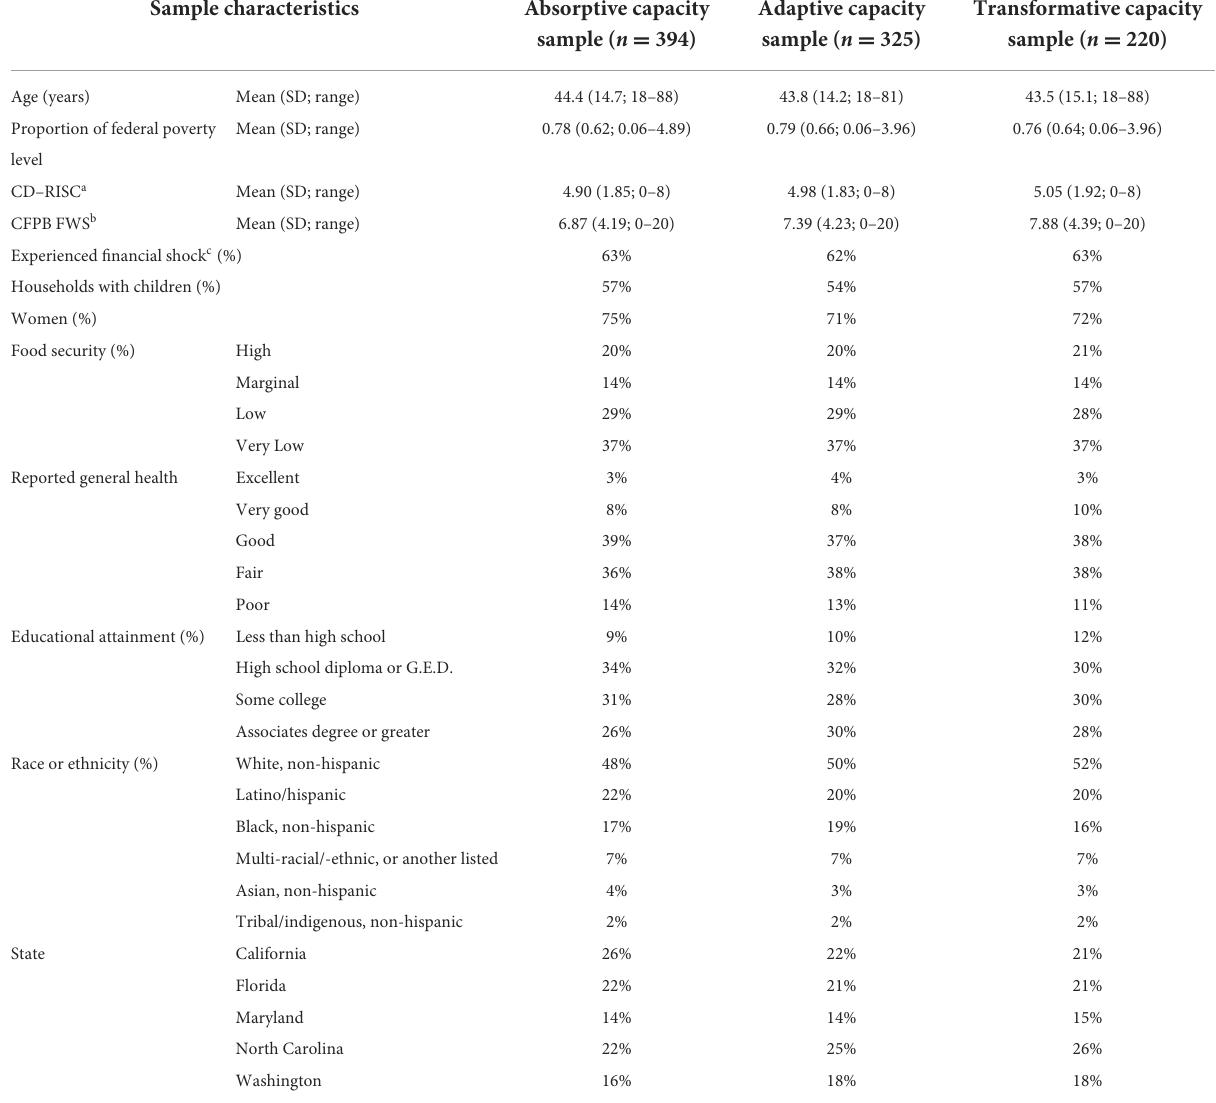
TABLE 1 Selected sample characteristics for the analytic samples for each of the new